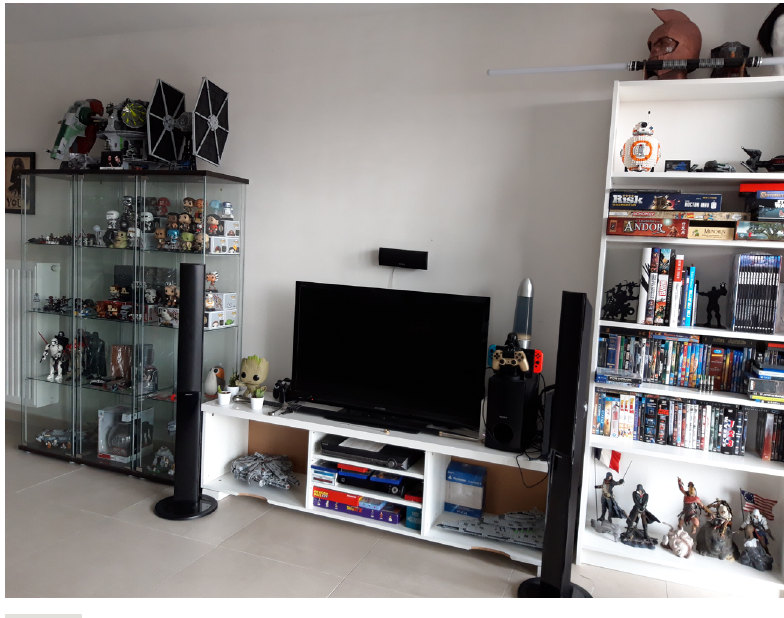
FIG. 8 Marvel and Star Wars collections and a home cinema in Leo’s